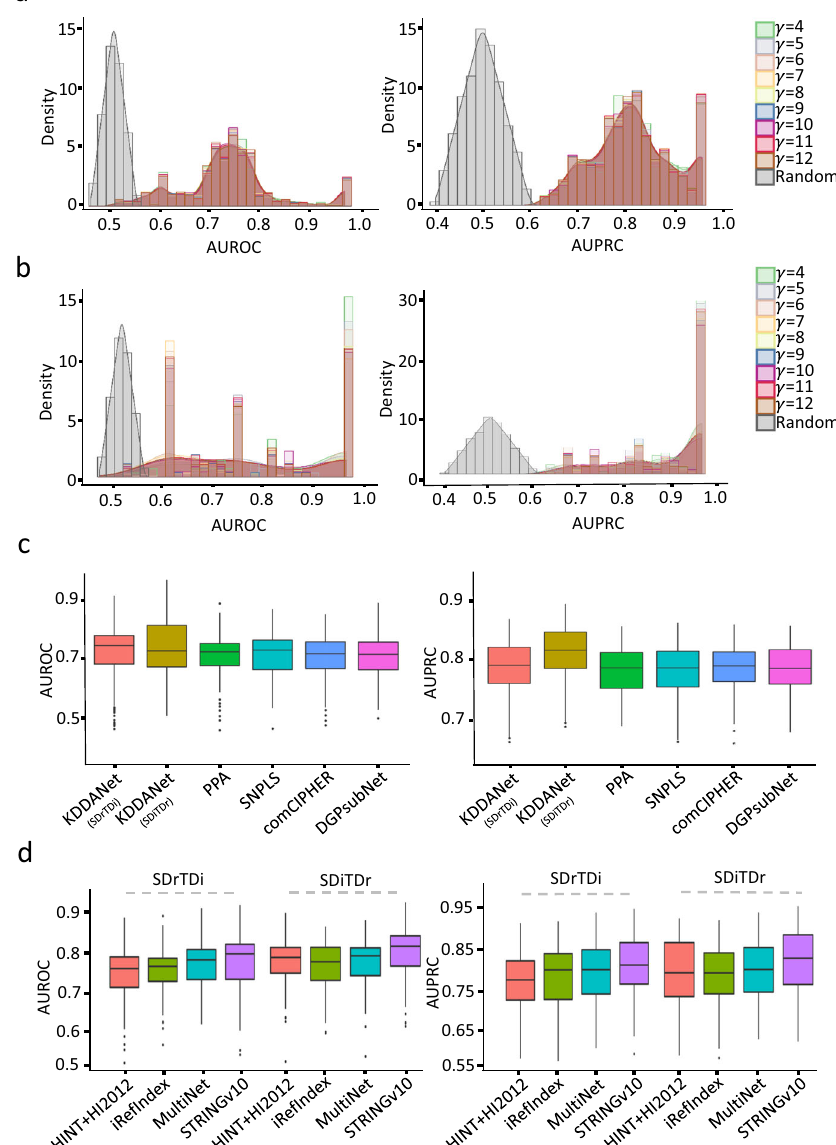
Fig. 2 Performance evaluation of KDDANet method. a The density curve of AUROC and AUPRC of KDDANet with different γ setting and permutation test in SDrTDi context. b The density curve of AUROC and AUPRC of KDDANet with different γ setting and permutation test in SDiTDr context. c Comparison of AUROC and AUPRC of KDDANet with PPA, SNPLS, comCHIPER, and DGPsubNet. d AUROC and AUPRC of KDDANet with different types of gene interaction